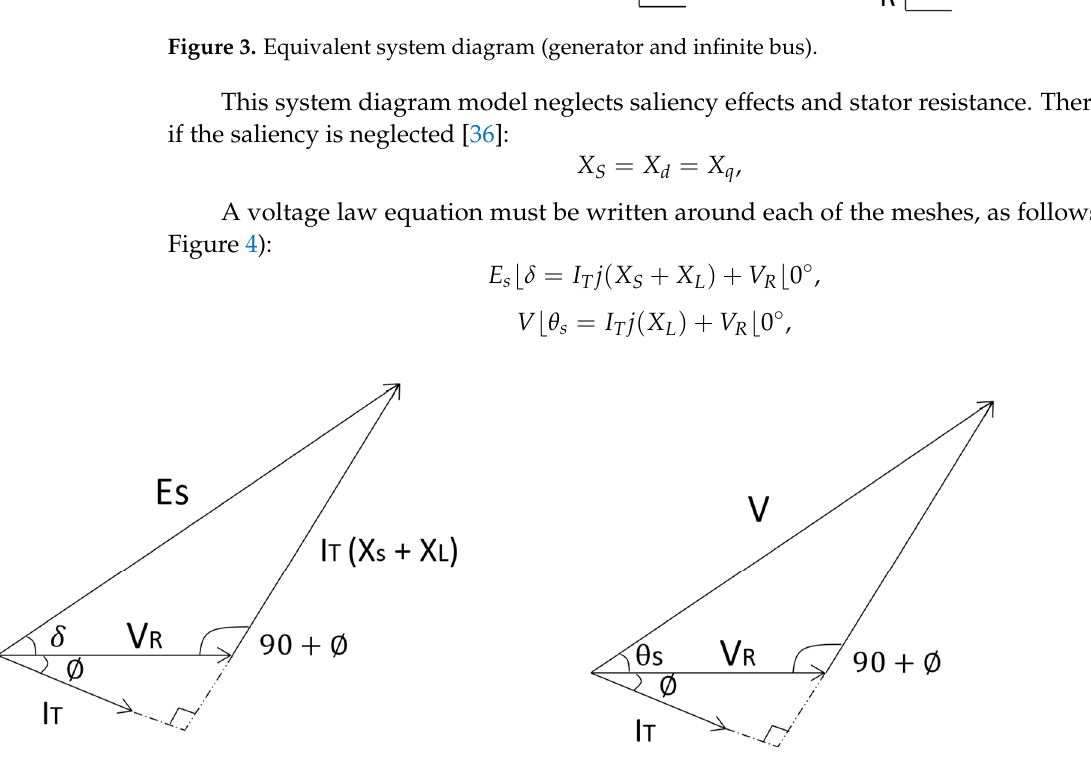
Figure 4. Steady-state phasor diagrams for Equations (7) ( left ) and (8) ( right ).